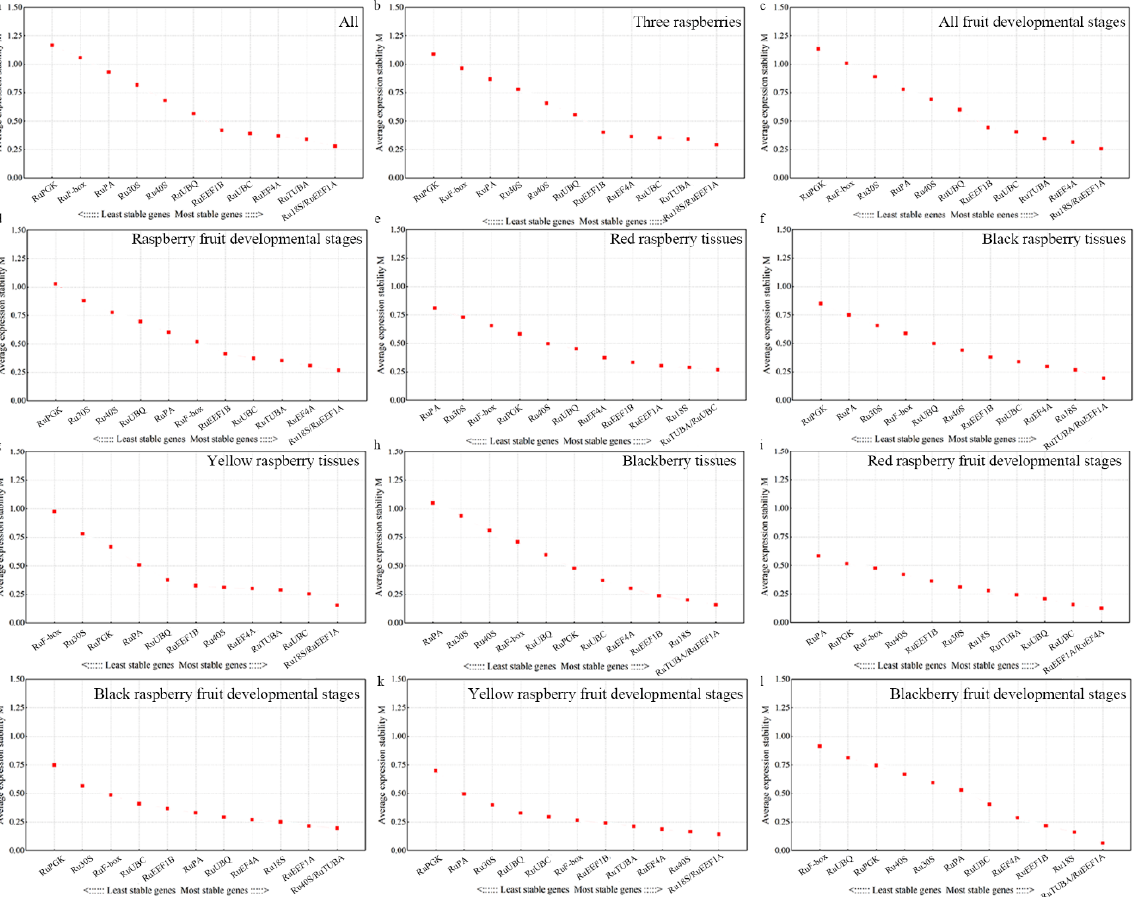
Figure 2. The average expression stability (M) values of the 12 candidate reference genes using geNorm analysis. Results from ( a ) All 72 samples; ( b ) Three raspberries; ( c ) All fruit developmental stages; ( d ) Raspberry fruit developmental stages; ( e ) Red raspberry tissues; ( f ) Black raspberry tissues; ( g ) Yellow raspberry tissues; ( h ) Blackberry tissues; ( i ) Red raspberry fruit developmental stages; ( j ) Black raspberry fruit developmental stages; ( k ) Yellow raspberry fruit developmental stages; ( l ) Blackberry fruit developmental stages. The least stable genes are listed on the left, while the most stable genes are listed on the right.